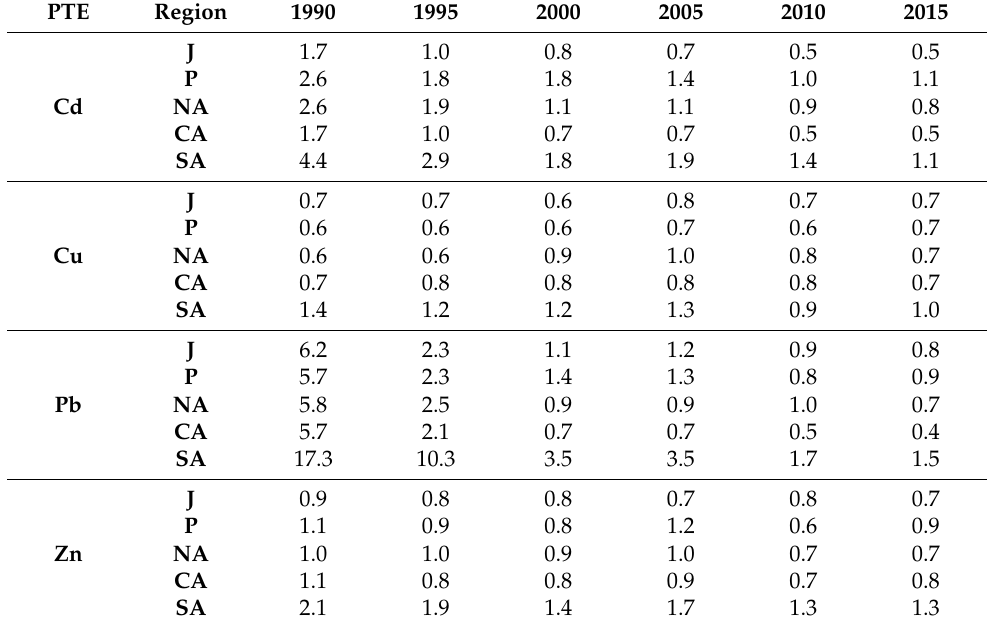
Table 3. Bioaccumulation ratios (median values) at the five Swiss biogeographic regions during the six European moss surveys, using whole-period background values. See Figure 1 for explanation of regions. PTE